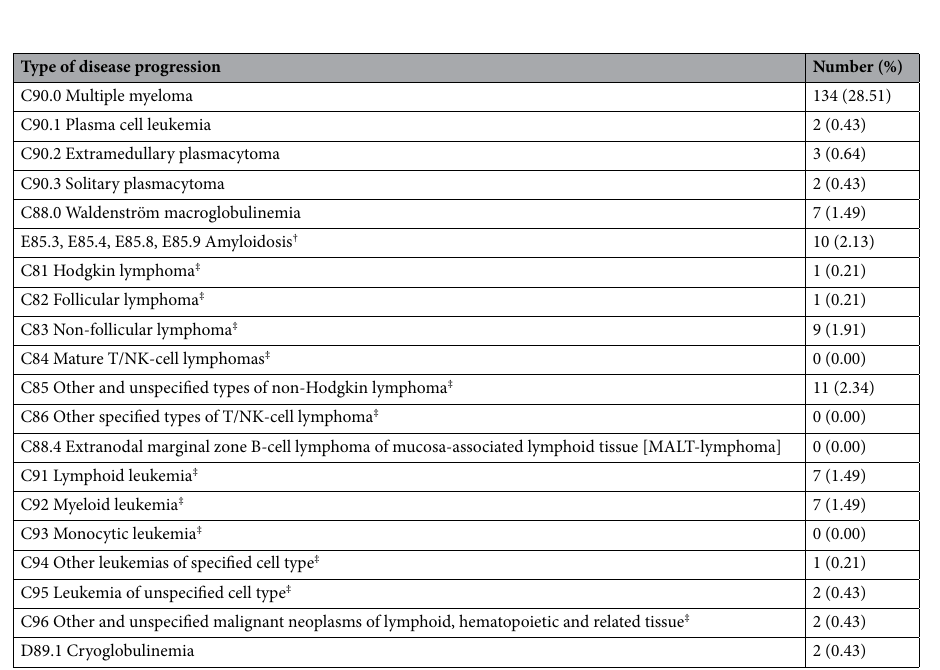
Table 2. Disease progression after the date of diagnosis of MGUS during the follow-up period. † Only secondary amyloidosis was selected. ‡ This entry includes all sub-codes.